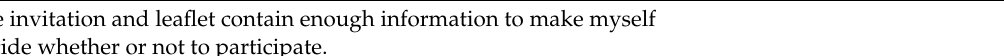
Table 2. Results of survey statements about ‘the need for more information after the FIT invitation and the role of the GPs (S3)’ in absolute numbers and weighted percentages.